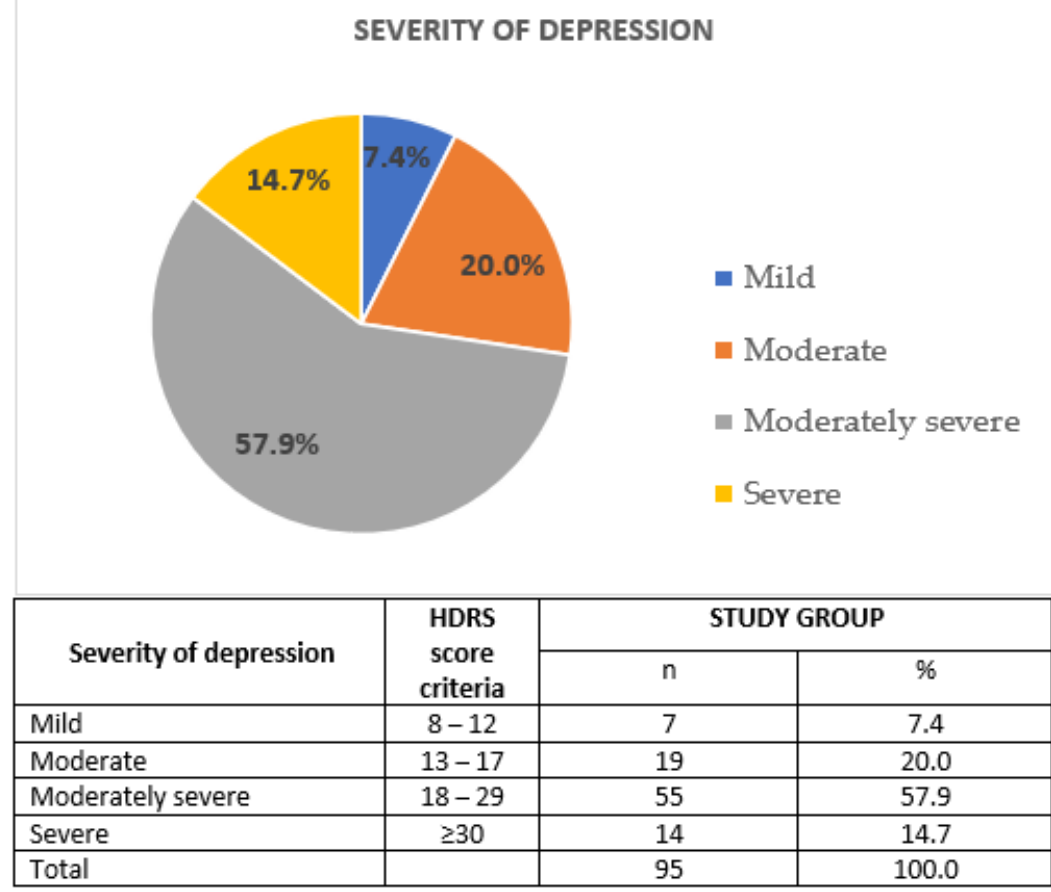
Figure 3. Severity of depression in the study group; HDRS: Hamilton Depression Rating Scale; n : sample size; %: percentage.